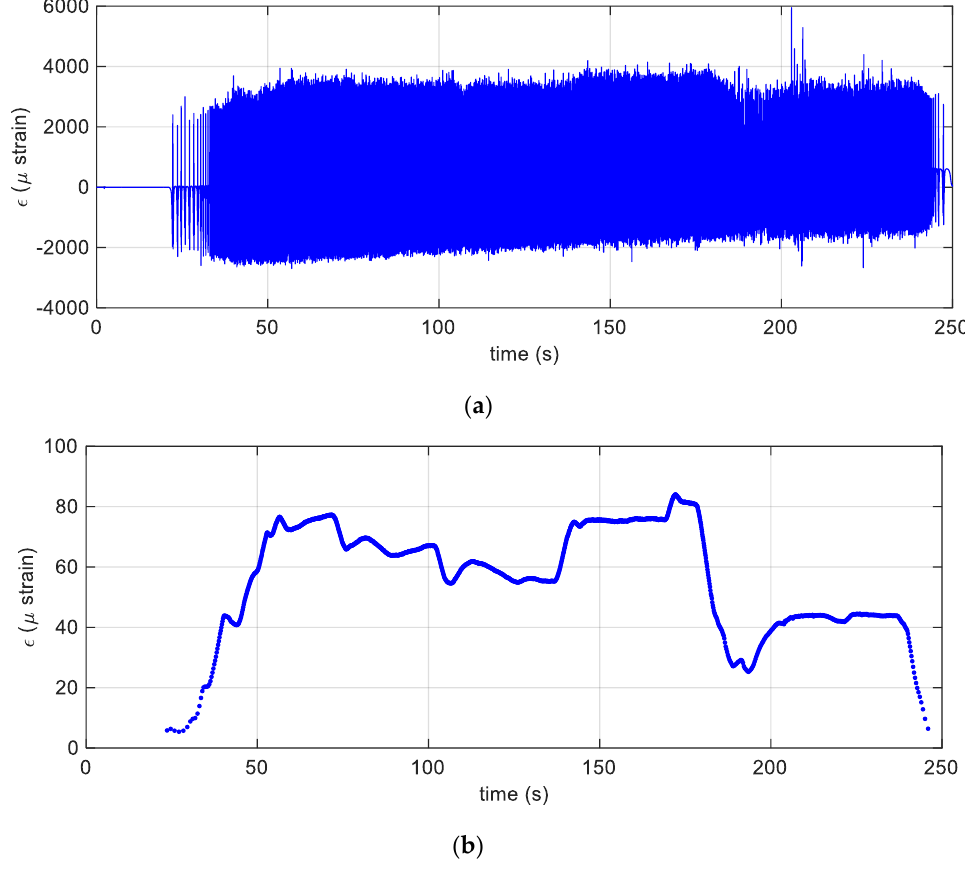
Figure 8. ( a ) The dynamic strain versus time; ( b) the estimated tyre velocity plotted versus time.